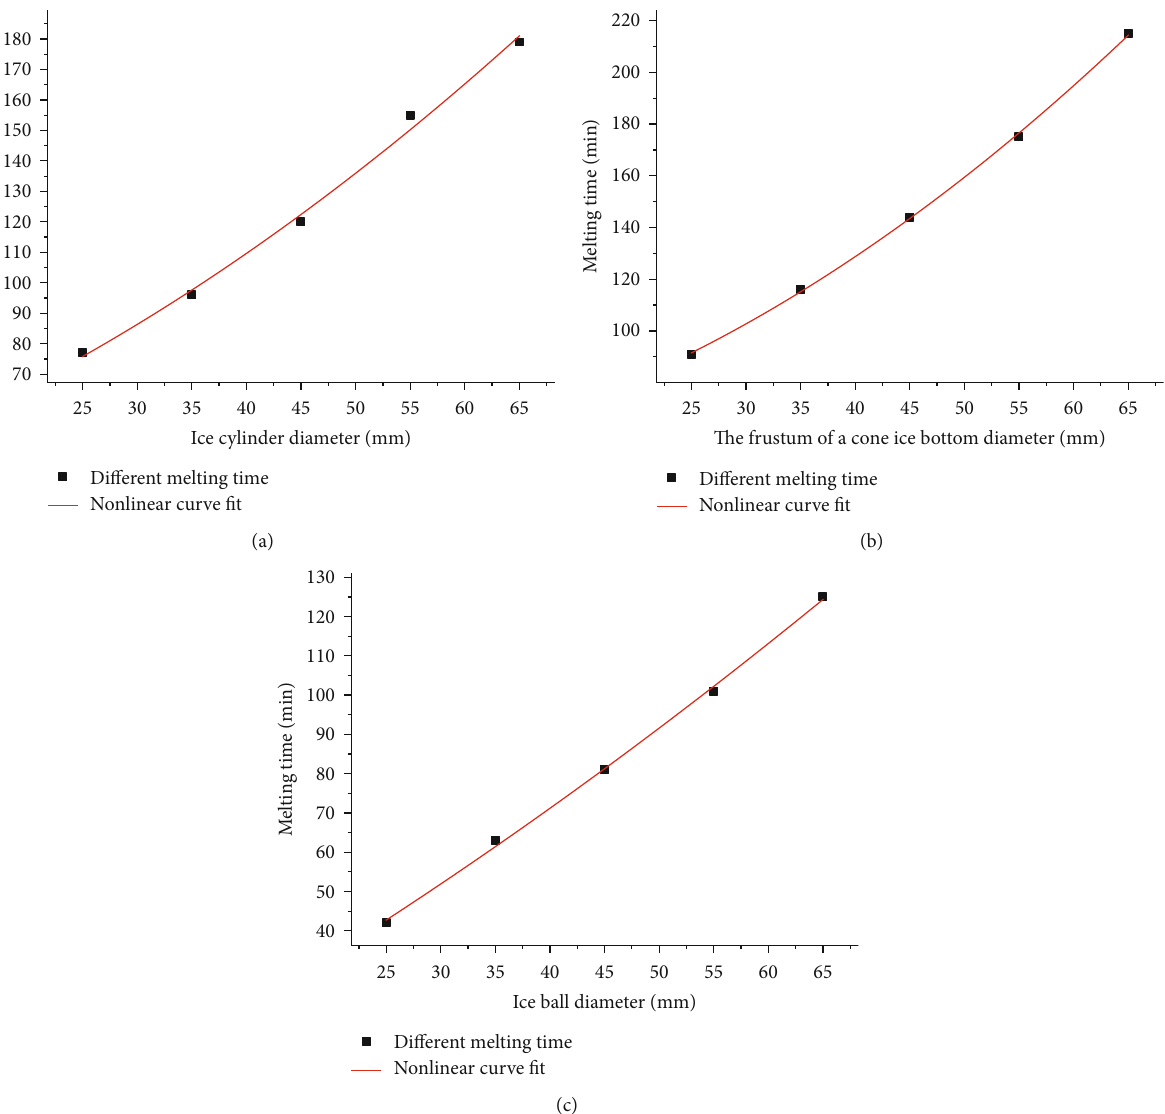
Figure 2: The nonlinear fi t between the melting time and diameter: (a) ice cylinder, (b) ice circular truncated cone, and (c) ice